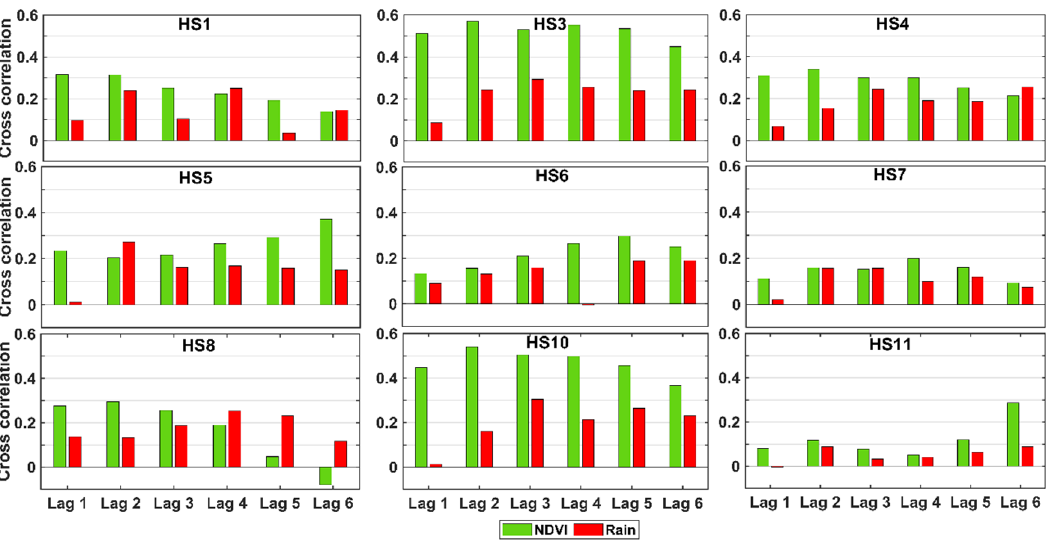
Figure 14. Time lag period cross correlation between GW and rain and NDVI by the hydrogeological sector (SH) from 2002 to 2016.